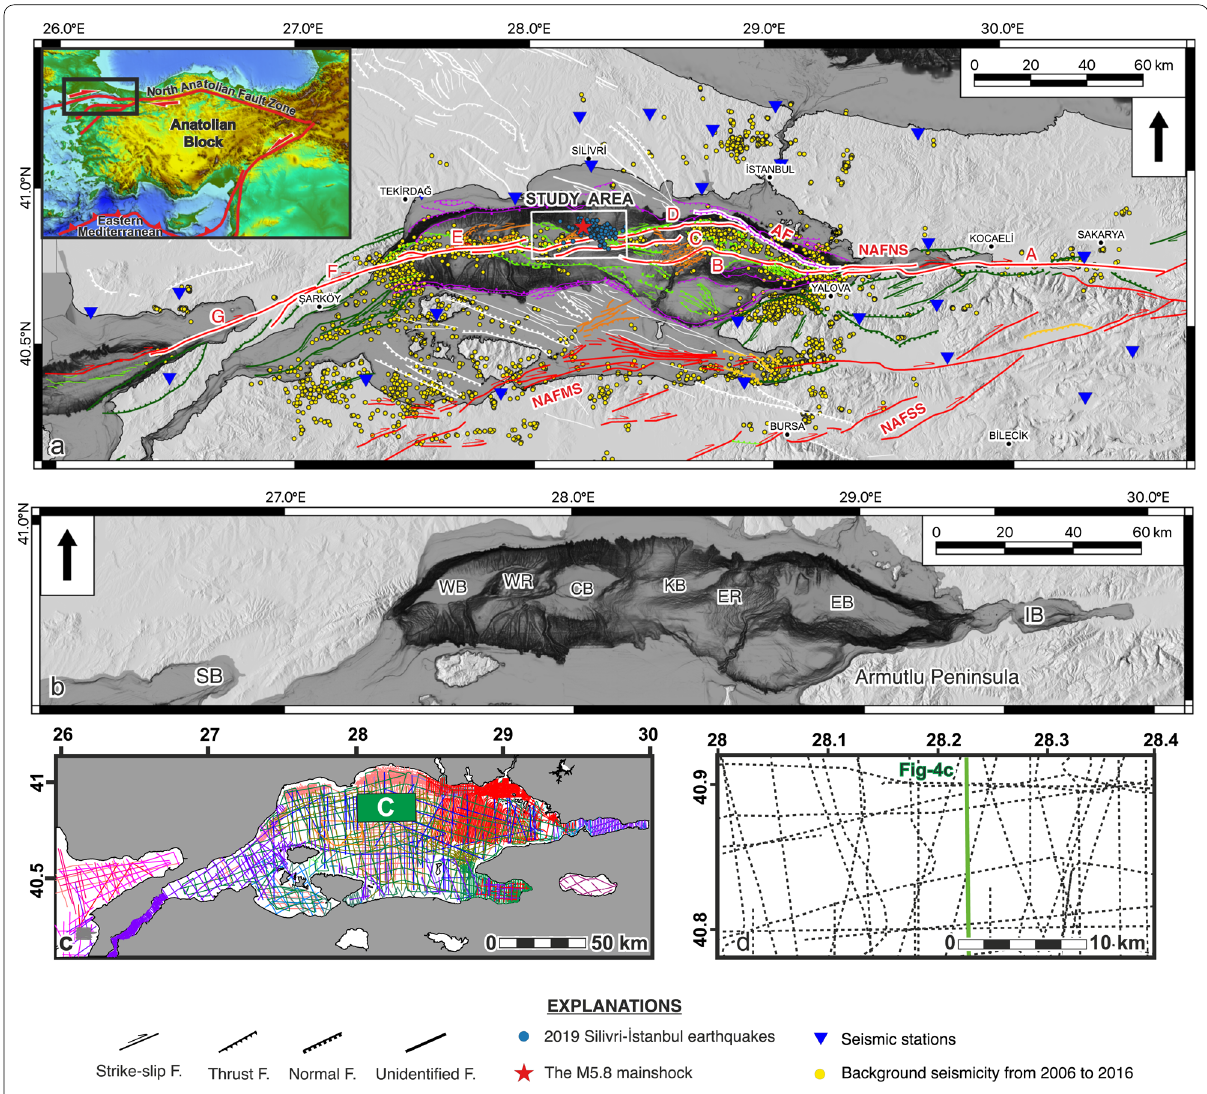
Fig. 1 a Seismotectonic activity and active fault map of the Marmara with main segments (this study). The letters from A to G indicate the previously identified seismogenic fault segment in the northern branch of the NAFZ along the Marmara Sea (adopted from Yaltırak (2015)). NAFNS North Anatolian Fault Northern Strand NAFMS North Anatolian Fault Middle Strand, NAFSS North Anatolian Fault Southern Strand, AF Adalar Fault. b Morphology around the northern branch of the NAFZ. IB Izmit Bay, EB Eastern (Çınarcık) Basin, ER Eastern Ridge, KB Kumburgaz Basin, CB Central Basin, WR Western Ridge, WB Western (Tekirdağ) Basin SB Saros Bay. c Distribution of the seismic profiles used in the compilation of the fault map. d Seismic profile coverage in the study area and the total length of the profiles is